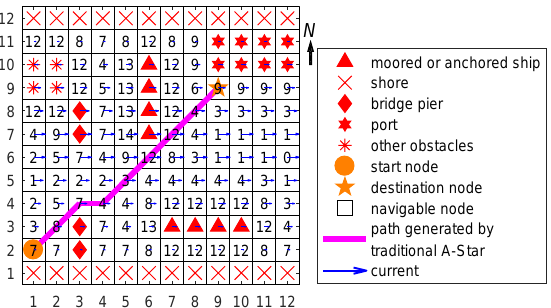
Figure 2. The grid map considering obstacles with current.